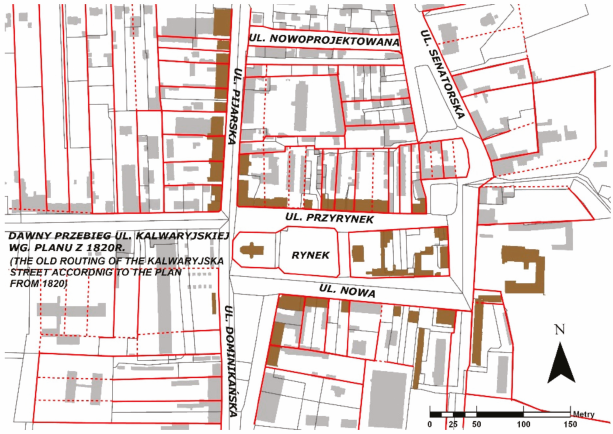
Figure 1. The contemporary city plan of the center of G ó ra Kalwaria, the structure of historical land divisions (into ‘semiagricultural’ plots of land in the form of long narrow strips) is marked in